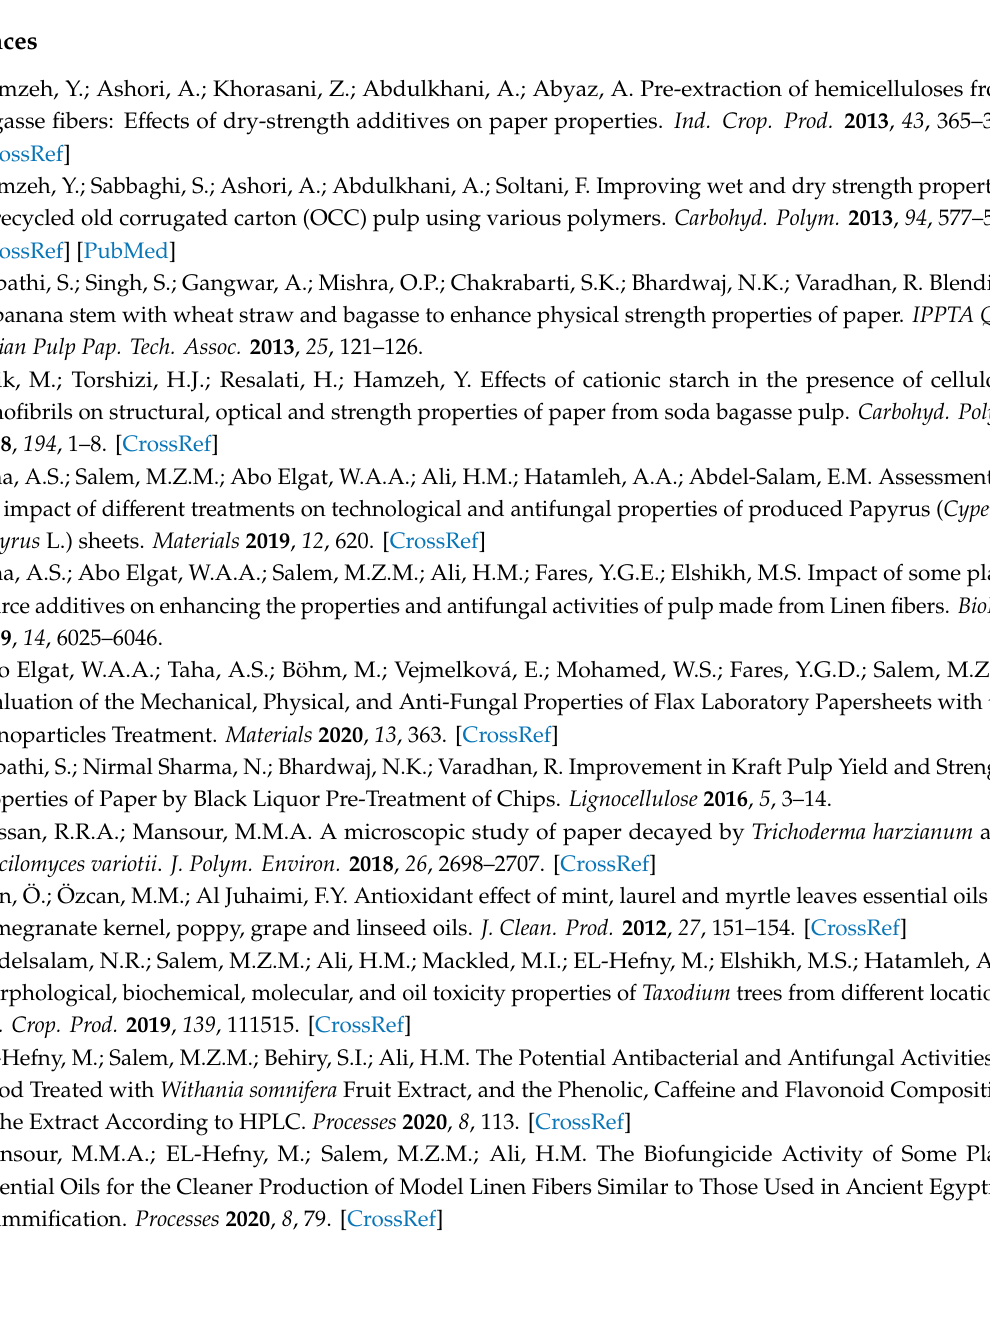
Table S1: Chemical composition of HeOE from S. alba seeds, Table S2: Chemical composition of HeOE from M. grandiflora leaves, Table S3: Chemical composition of HeOE from M. azedarach